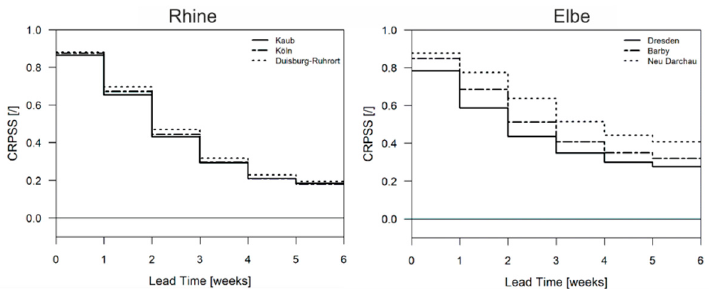
Figure 7. Verification using the CRPSS for the 6-week forecast at 3 gauges at Rhine (left column) and Elbe (right column) for the period March 2016–March 2022 (reference forecast: climatology).